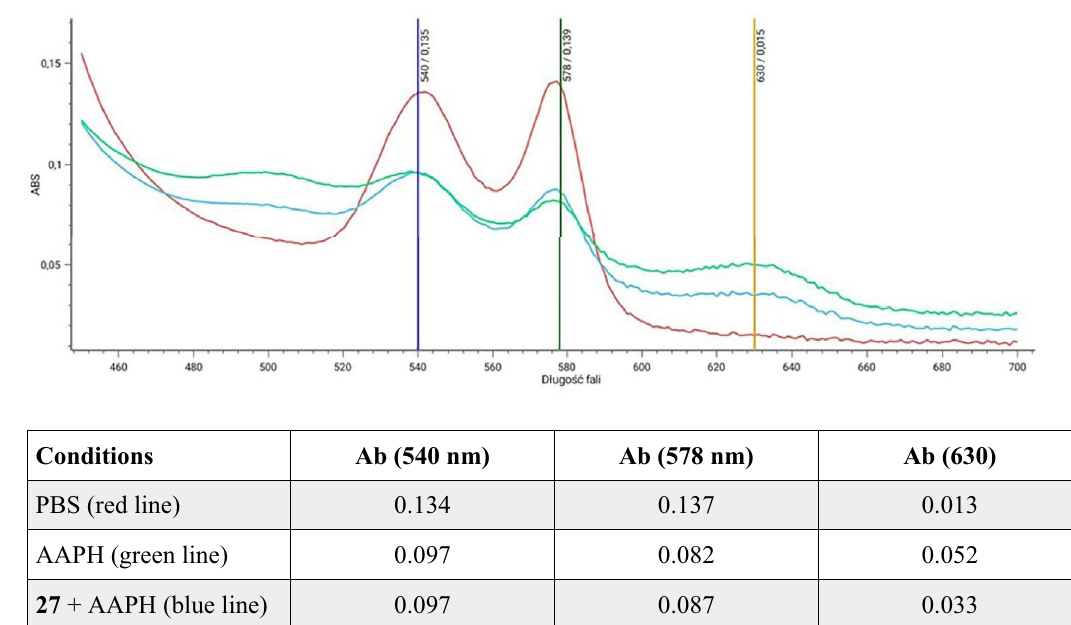
Figure 5. Spectral scans (450–700 nm) of hemoglobin (Hb) in supernatants after 4 h of incubation of RBC in PBS (red line), 60 mM AAPH (green line), derivative 27 (0.1 mg/mL) and 60 mM AAPH (blue line). Absorbance values (Ab) measured at 540, 578 (oxy-Hb peaks), and 630 nm (MetHb peak) are presented for every scan. The representative data for a series of experiments are